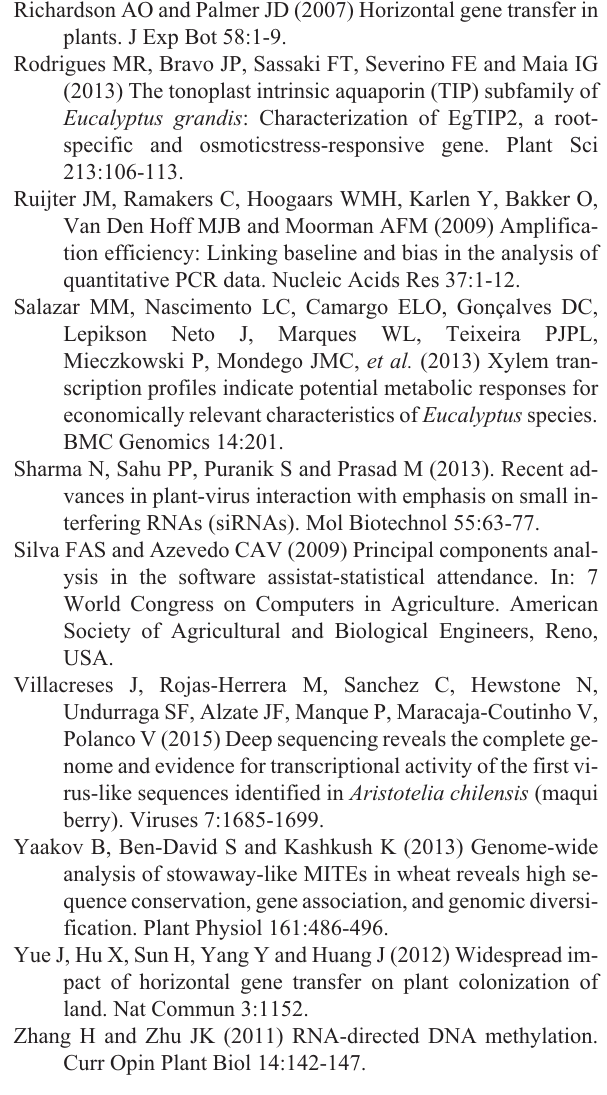
Table S1 - Distribution of EVE elements in Eucalyp- tus grandis genome. Table S2 - Expressed sequence tags (ESTs) matching to EVE elements. Table S3 - sRNAs mapped to Eucalyptus EVEs. Figure S1 - Phylogenetic analysis of reverse tran- scriptase domain from EgEVE